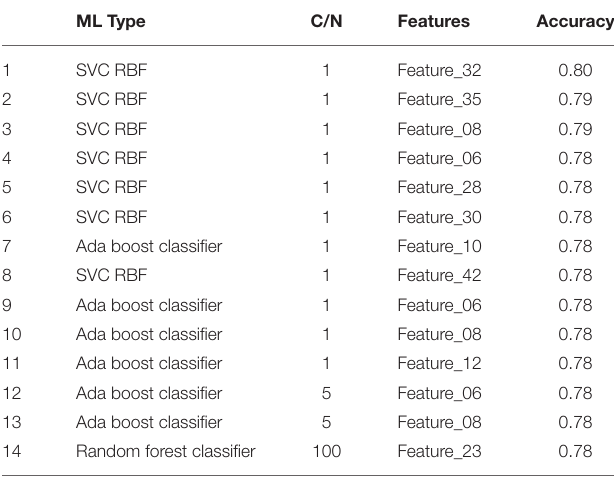
TABLE 7 | Median of a specific ML accuracy for the best feature list, where C/N refers to a tuning parameter in the machine learning. ML